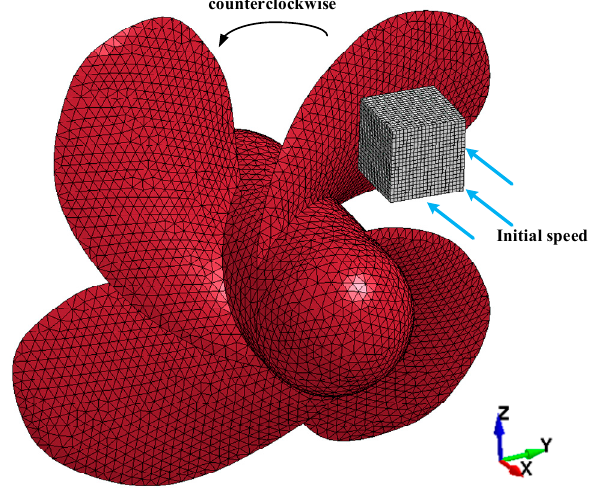
Figure 4. The numerical model of ice block impacting propeller.